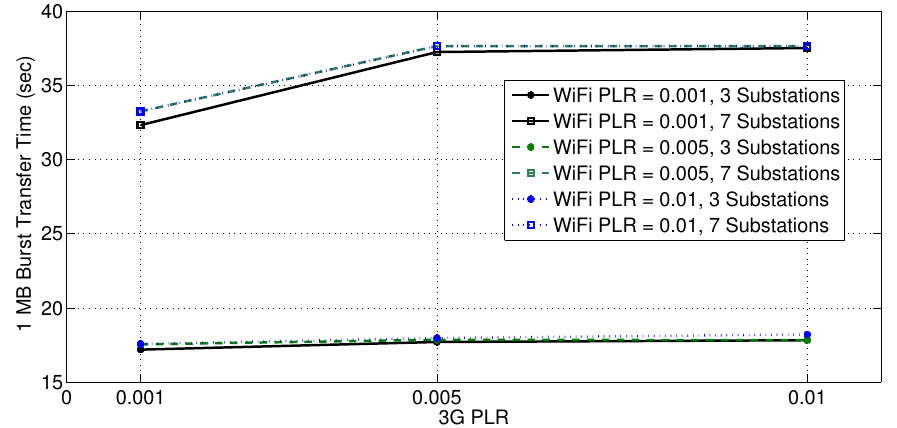
Figure 6. Data burst transfer time for different number of substations and PLRs.